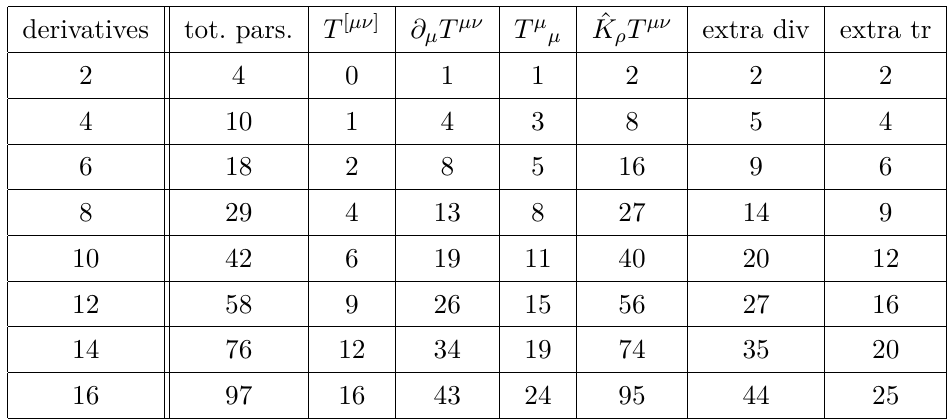
Table 2 . In each row we list the number of independent constraints on the parameters of T µν as a result of the corresponding